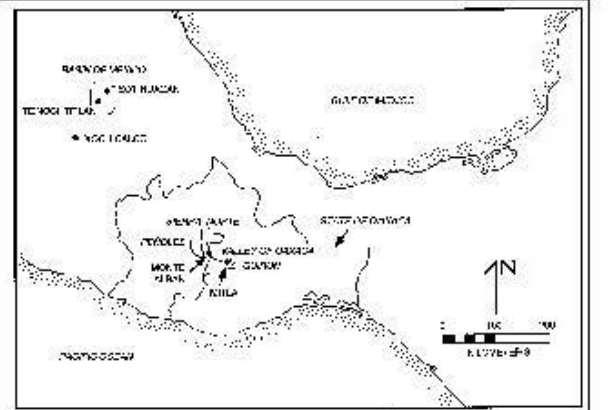
figure I. Map ofMcsoamcrica, sho'INingprincipal sites and places mentioned in text. [Page